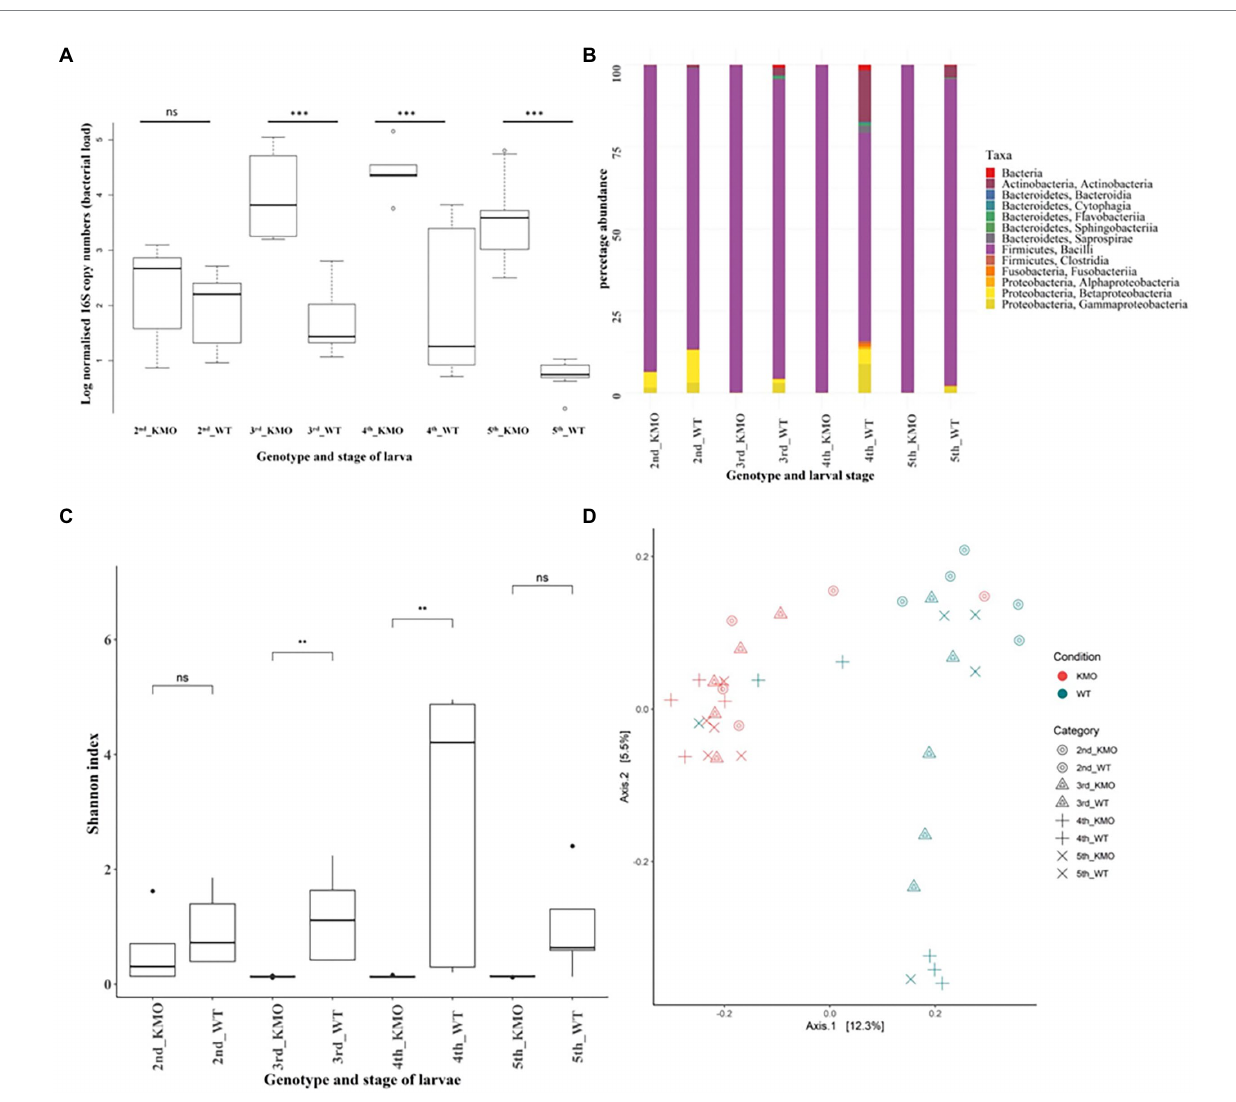
FIGURE 4 Bacterial abundance and composition in wild-type and KMO knockout larvae. (A) 16S rRNA gene copy numbers signifying the bacterial abundance as determined by quantitative PCR during different stages of the life cycle of S. littoralis (2nd, 3rd, 4th and 5th instars) and the genotypes of KMO-ko and WT. The KMO-ko harbor a higher bacterial number than their corresponding WTs. (B) Comparison of relative microbial composition at the phylum level in KMO-ko vs. WT S. littoralis through the larval instars. (C) Box plot for comparison of alpha diversity of species in KMO-ko and WT guts of S. littoralis , through the larval instars, based on Shannon (species richness) index of alpha diversity (Wilcoxon test p < 0.05 for 3rd and 4th instars). (D) Beta diversity analysis between the KMO-ko and WT lines of S. littoralis guts by Canberra distances on PCoA plot (Adonis test p = 0.001). Each point represents an individual sample and clustering of points indicates similarity of bacterial composition in the